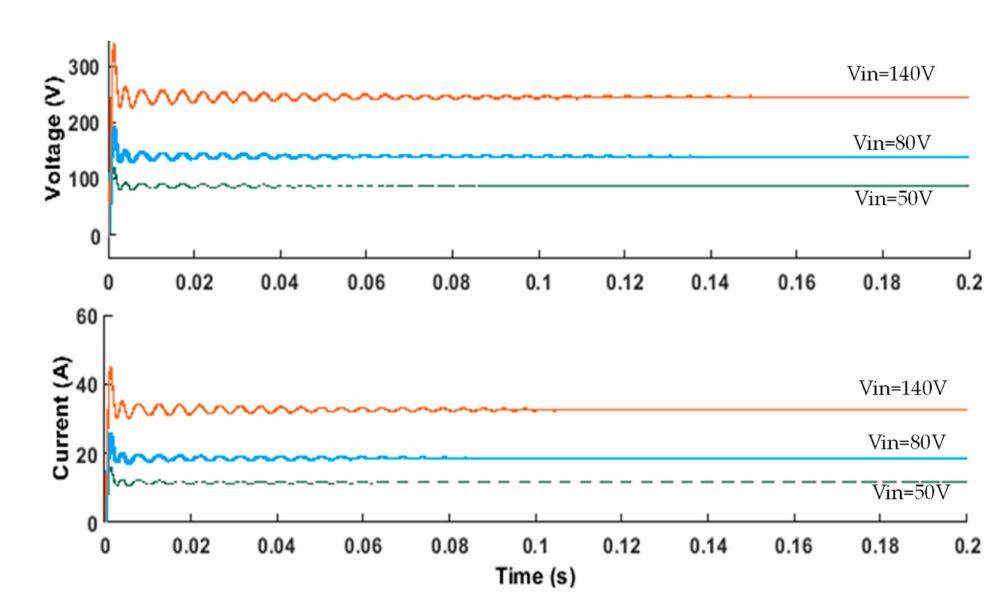
Figure 13. SEPIC converter output voltage and current at variable input